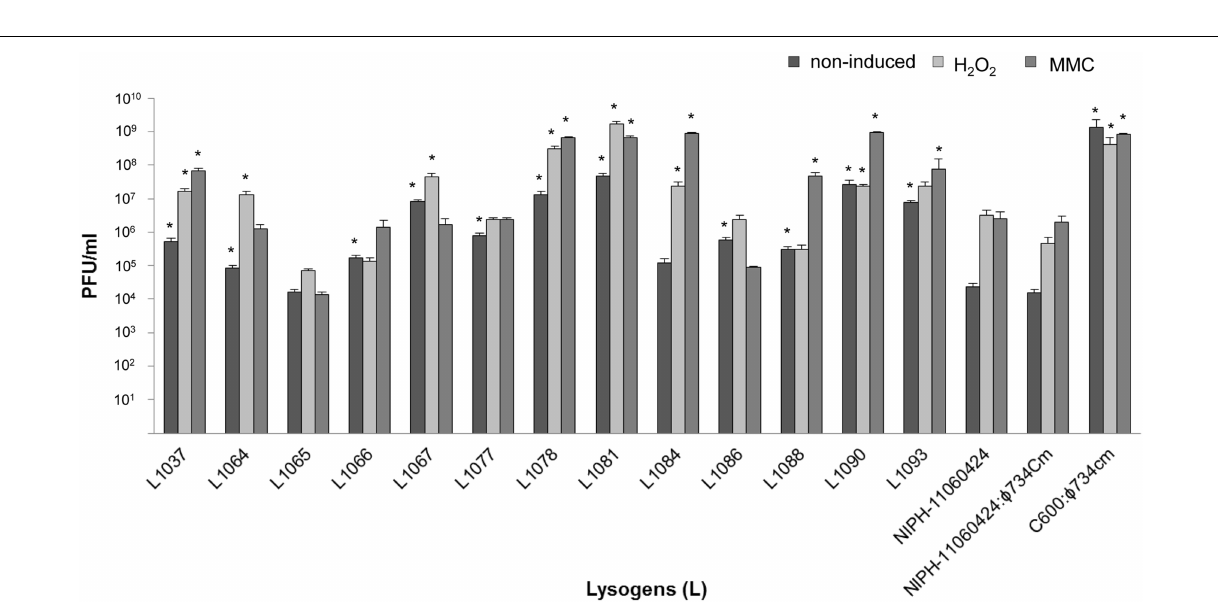
standard error of the mean (SEM) of three independent experiments. An asterisk indicates statistical significant difference ( P < 0 . 05) in phage titer from lysogen compared to corresponding phage titer from